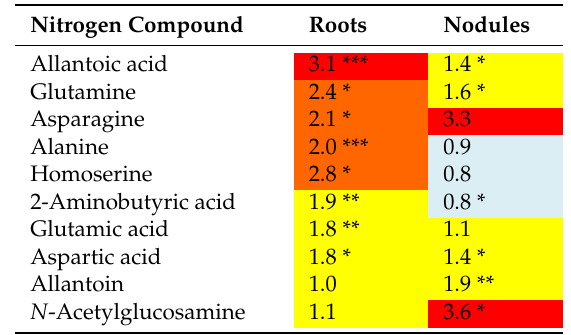
Table 1. Comparison of the ratios of concentrations of nitrogen compounds in soybean roots and nodules treated with 5 mM of nitrate for 24 h and the control plants.